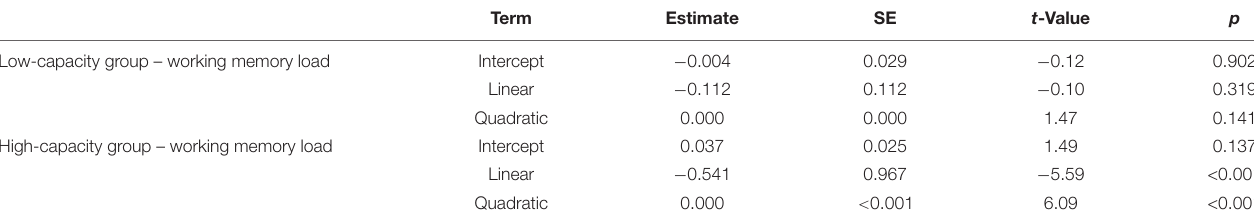
TABLE 5 | Results of growth curve analysis (GCA) conducted separately for each WM capacity